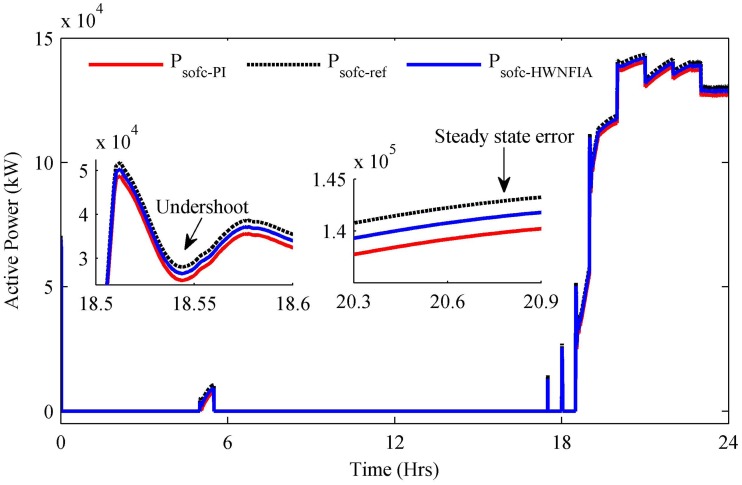
SOFC output power.